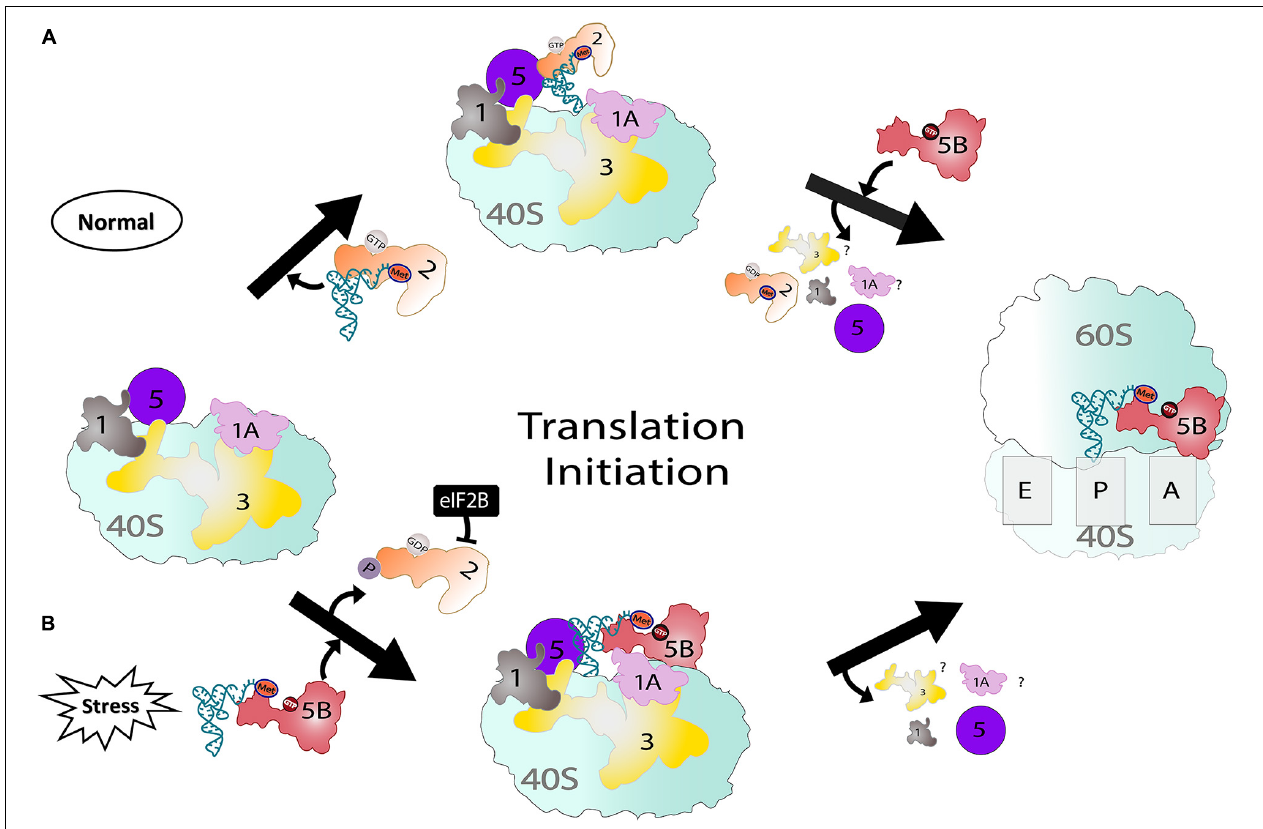
FIGURE 1 | Two pathways showing eIF2-dependent (normal) and eIF5B-dependent translation (stress). (A) Under normal conditions, eIF2 delivers Met-tRNA iMet to the ribosome and, upon release of eIF2, eIF5B stabilizes Met-tRNA iMet . Once 48S PIC forms, eIF5B assists in large and small ribosomal subunit joining. (B) Under stress conditions, eIF2 is phosphorylated and sequestered by eIF2B. However, eIF5B parallels the role of eIF2 and delivers Met-tRNA iMet to the P-site of the 40S ribosome in addition to its usual function during